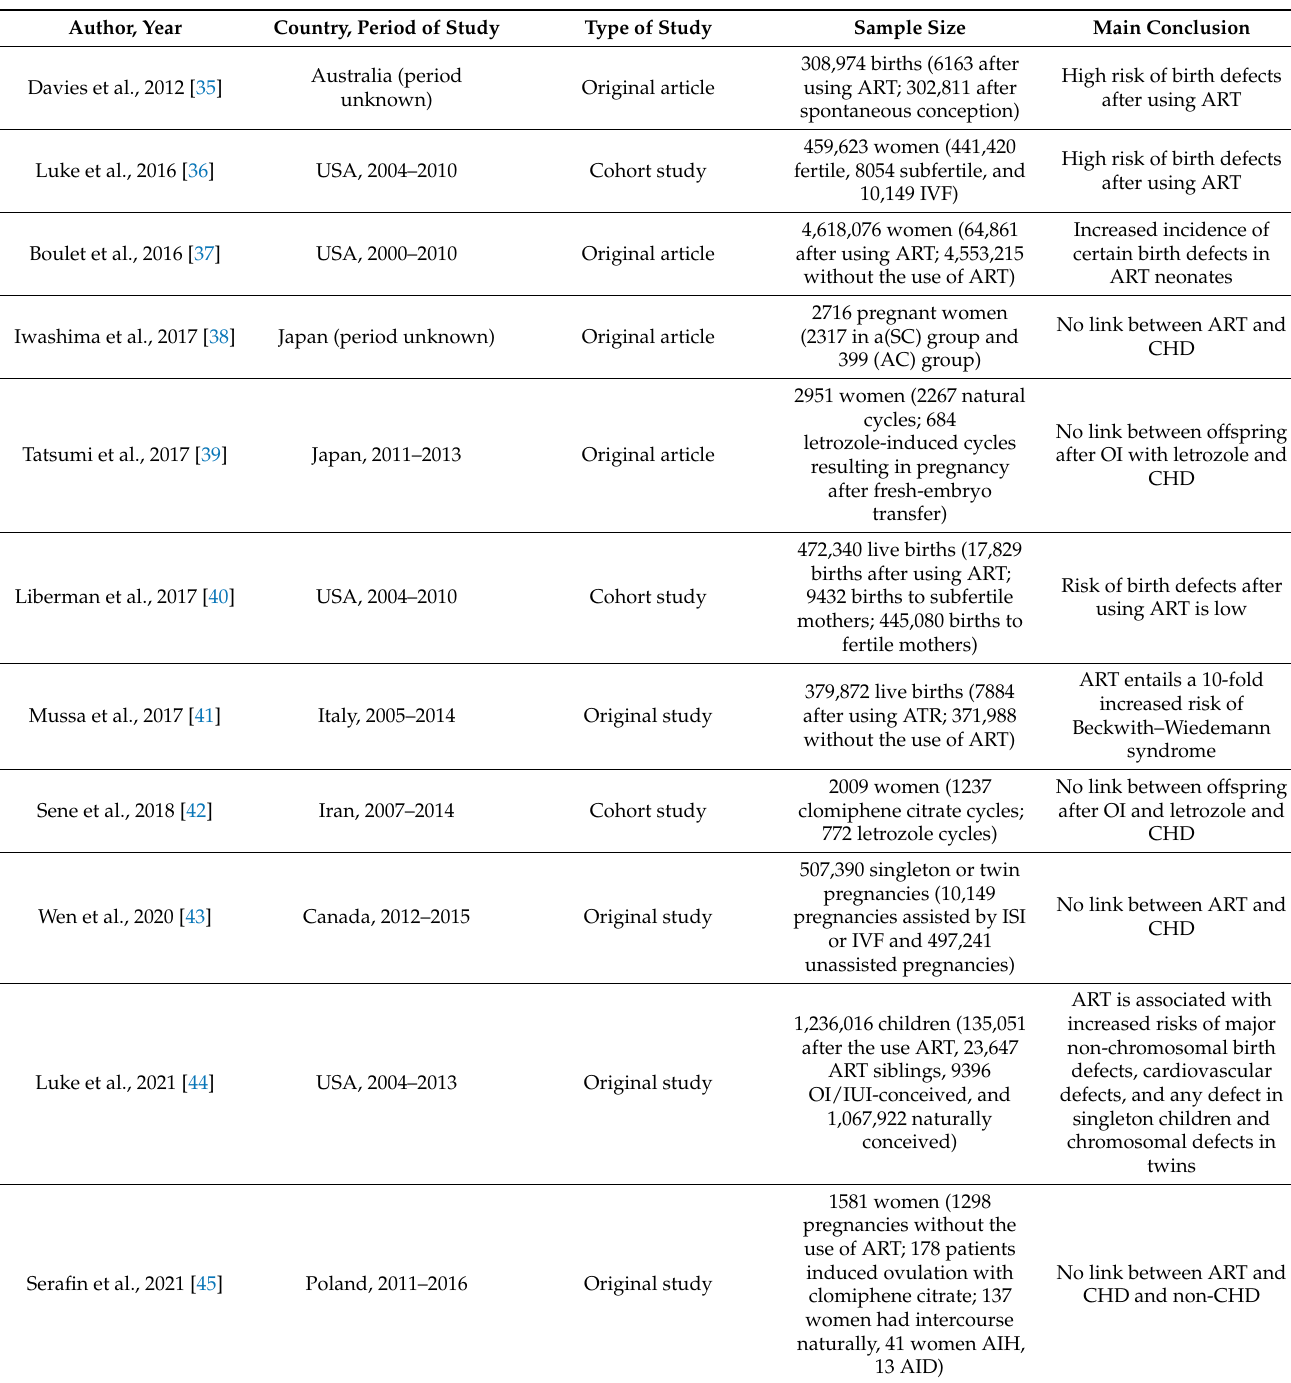
Table 2. Characteristics of the included